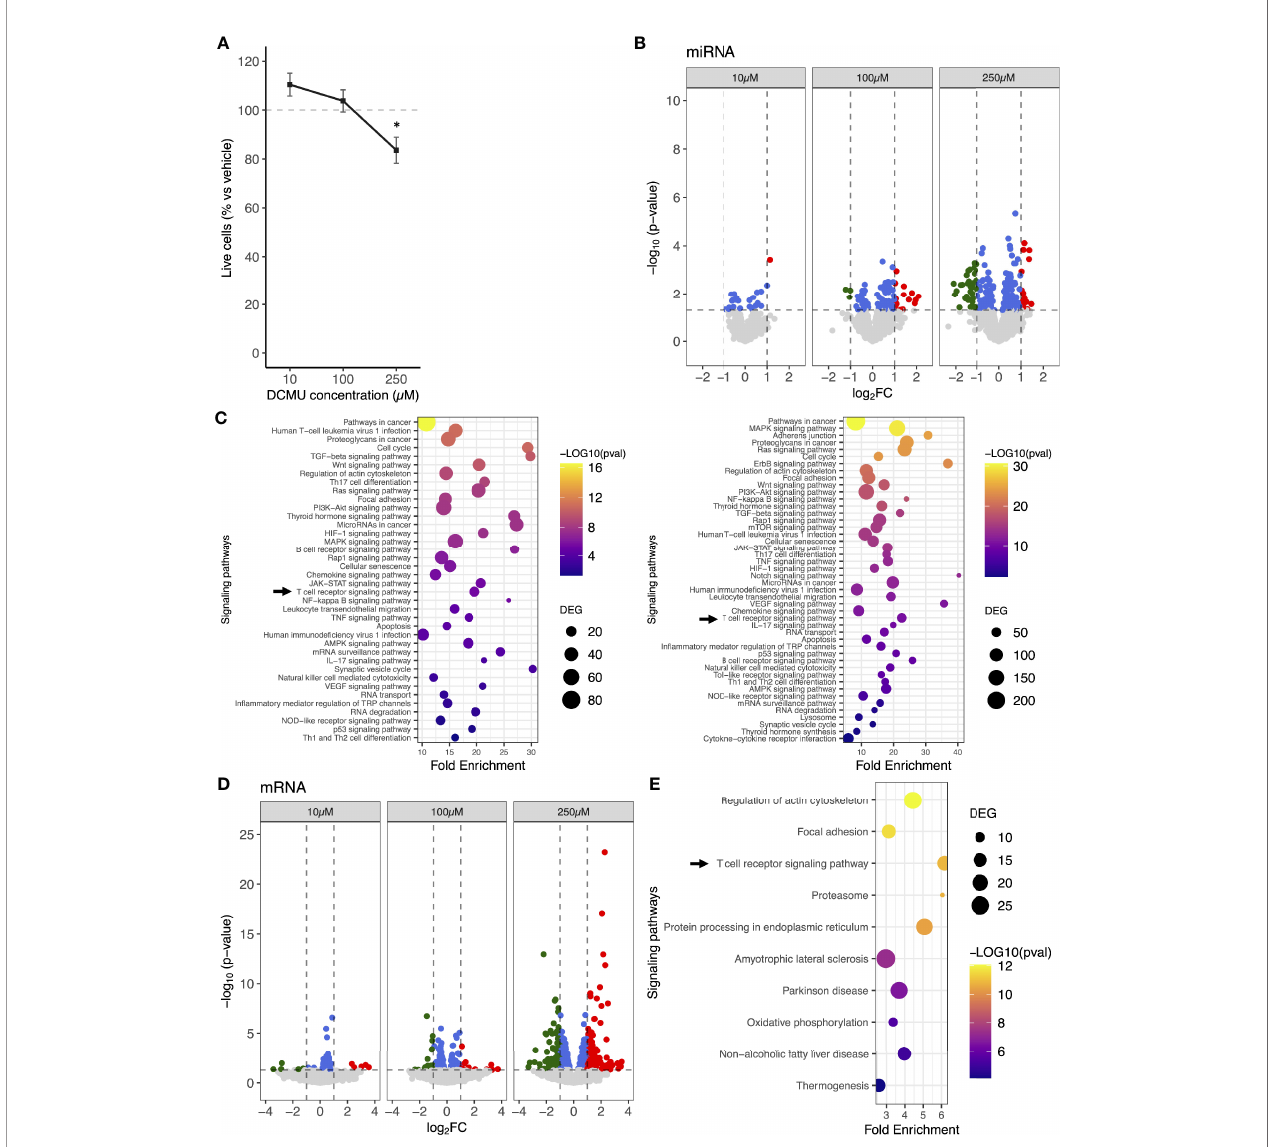
FIGURE 1 | miRNA and mRNA expression changes in human CD8+ T cells following DCMU exposures. (A) Cell viability assay of CTL03.1 cells exposed to increasing DCMU concentrations. (B) Volcano-plot of the differentially expressed miRNAs. Red: signi fi cant upregulation, Green: signi fi cant downregulation, Blue: sign fi cant but under the fold-change (FC) cutoff. FC cut off ≥ 1 or ≤ -1. (C) KEGG pathways enrichment of the DCMU-dysregulated miRNAs at 100µM (left panel) or 250 µM (right panel). (D) Volcano-plot of the differentially expressed mRNAs. Red: signi fi cant upregulation, Green: signi fi cant downregulation, Blue: sign fi cant but under the fold-change (FC) cutoff. FC cutoff ≥ 1 or ≤ -1. (E) Top 10 of KEGG pathways enrichment of the DCMU-dysregulated ( Figure 1D ; Supplementary Table S3 ). KEGG pathway analysis showed that the dysregulated mRNAs were signi fi cantly enriched for various functions ( Supplementary Figure S1 ), including the the enriched pathways at 250 µM of DCMU ( Figure 1E ).